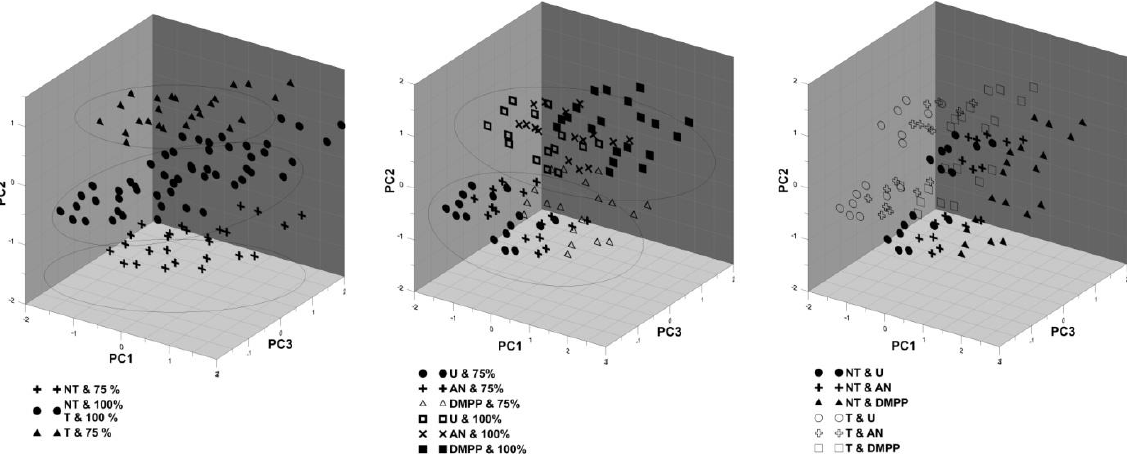
Figure 6. Spatial representation of the main components as a function of the interaction of the variables studied in pairs.